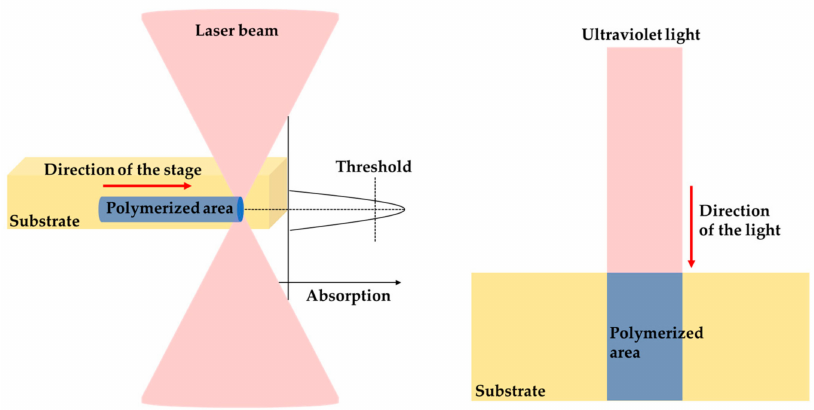
Figure 4. Schematic of two-photon lithography ( left ) and UV lithography ( right ).